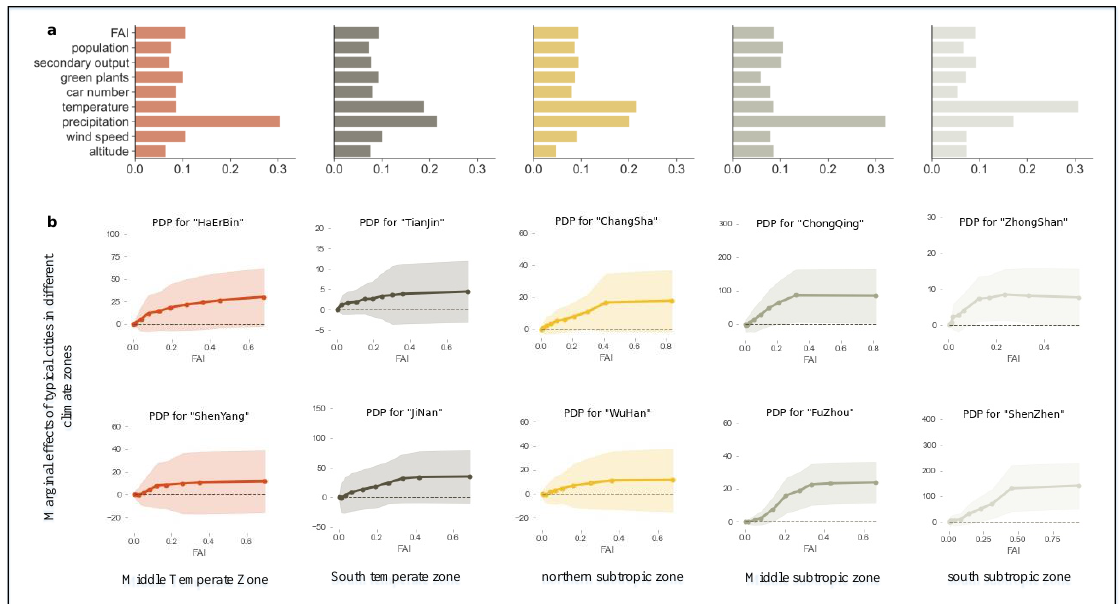
Figure 6. Relationship between FAI and NO 2 concentration. Different colors indicate different temperature zones: ( a ) the contribution of FAI to NO 2 concentration in different climate zones; ( b ) the dependence plots of cities in different climate zones.